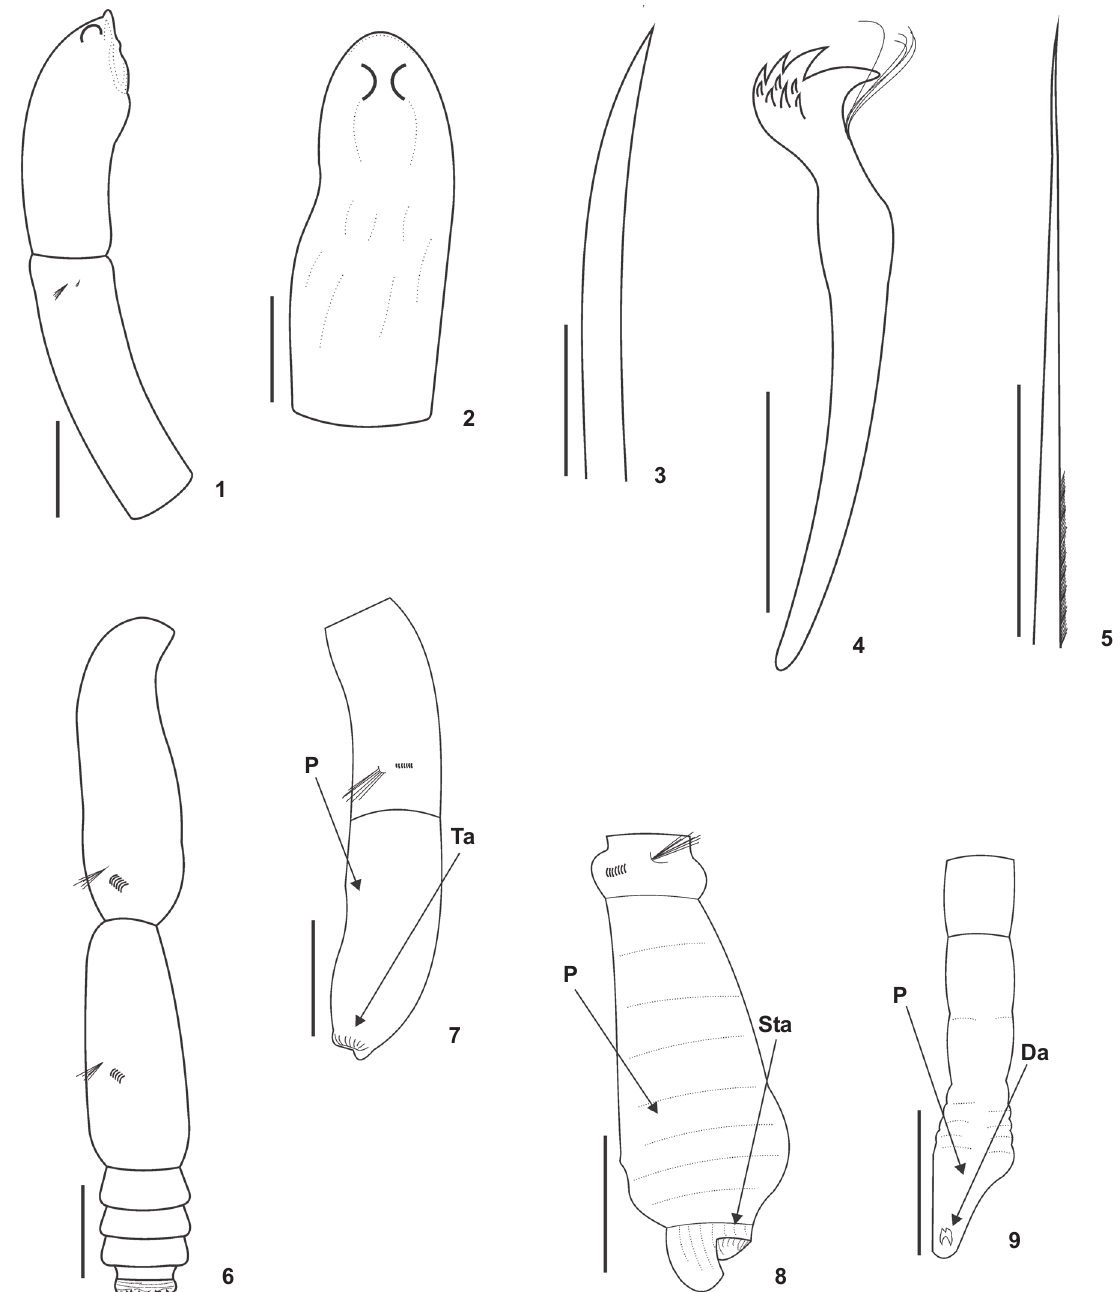
Figures 1-9. (1-6) Lumbriclymene interstricta comb. nov. : (1) anterior end of holotype, lateral view; (2) head, in dorsal view; (3) acicular spines from chaetiger 3; (4) rostrate uncinus from chaetiger 17; (5) capillary chaetae, with base ruffled, from chaetiger 17; (6) posterior end holotype, showing four achaetigers pre-anal segments and pygidium. (7-9) Position of the anus in Lumbriclymene , according to the species complex: (7) terminal anus (complex one), from Lumbriclymene nasuta modified from T READWELL (1948); (8) sub-terminal dorsal anus (complex two), from Lumbriclymene fusca modified from D ETINOVA (1984); (9) dorsal anus (complex three), from Lumbriclymene minor modified from D AY (1967). (P) Pygidium, (Ta) terminal anus, (Sta) sub-terminal anus, (Da) dorsal anus. Scale bars: 1-2, 6-9 = 1 mm, 3-5 = 0.5 ZOOLOGIA 27 (6): 1008–1013, December, 2010